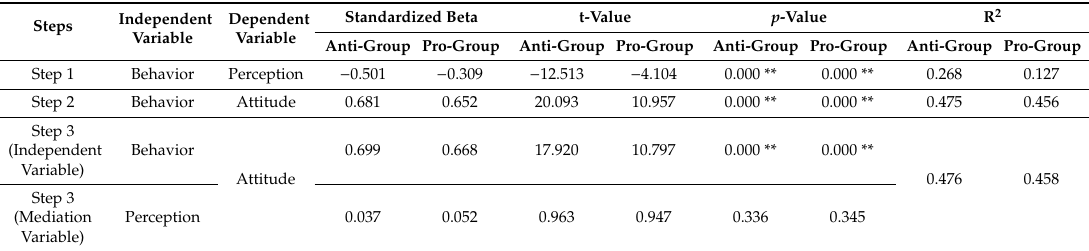
Table 9. Hedonic models for the anti-group and the pro-group.